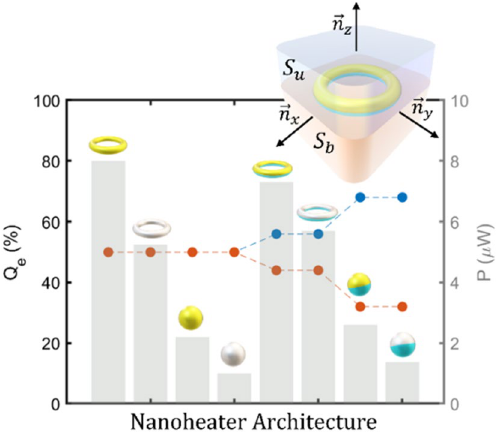
Figure 3. Comparative of the relative conductive heat power ( Q e ) flowing through the upper half-space (in blue) and lower half-space (in orange) for single material and hybrid nanoparticles irradiated with a power density of 0.1 mW/μm 2 at the resonance. The grey bars correspond to the total heating power for each architecture. Inset: Scheme of the conductive thermal power calculation method applied to the nanoheaters where S u y S b are the upper and bottom half-spaces respectively. n x , n y and n z are the canonical basis